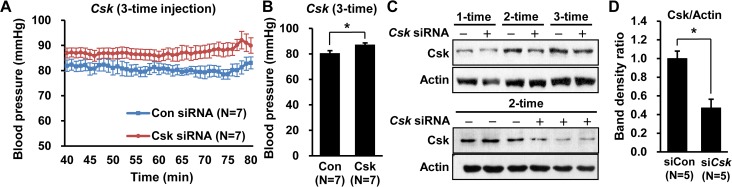
Increase in blood pressure in 3-time Csk siRNA-injected mice and change in protein levels in Csk siRNA-injected mice.(A) The line graph and (B) the bar graph show blood pressure from 40 min to 80 min after anesthesia in 3-time Csk siRNA-injected mice. (C) Csk protein levels in lung are shown for 1-, 2-, and 3-time siRNA injected mice following Western blotting. (D) Csk protein levels in lung are presented as the ratio of 5 independent protein band densities for 2-time siRNA injected mice.